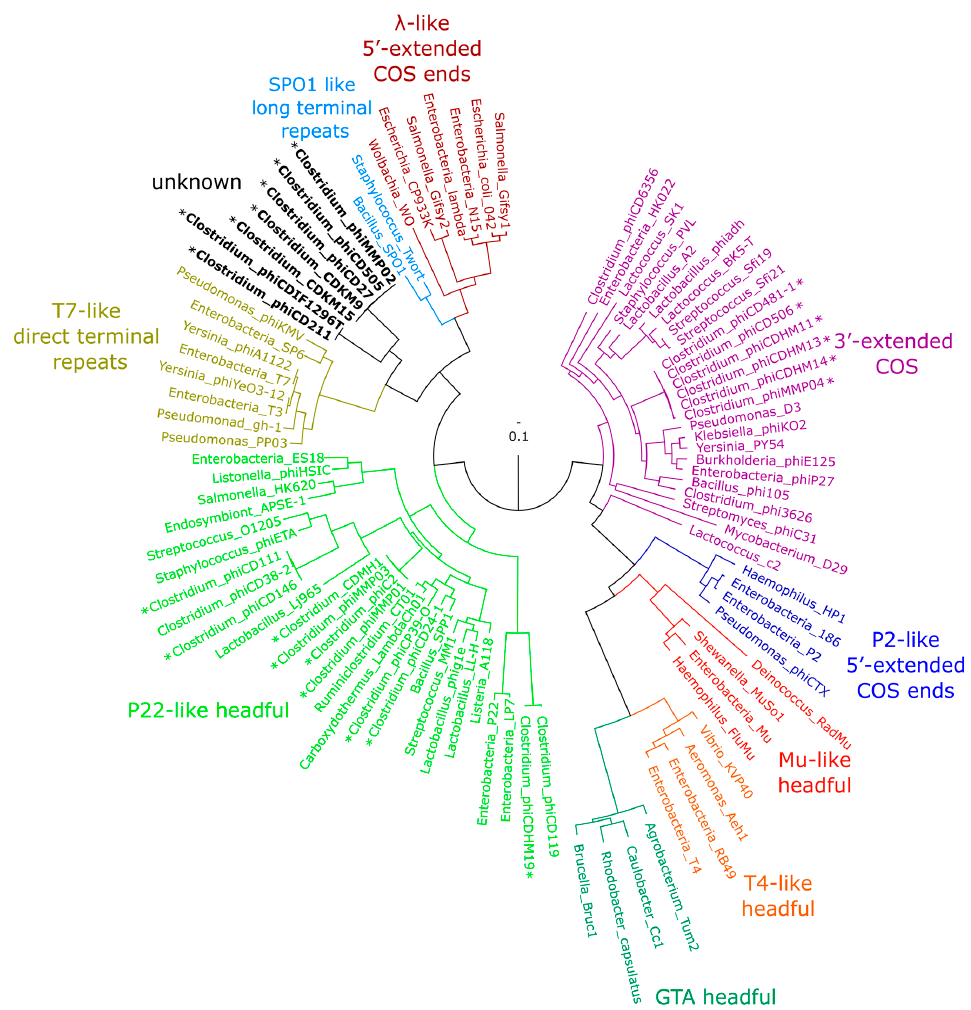
Figure 7. Phylogenetic tree of phage terminase large subunit ( terL ) gene. The name of the phage or prophage is shown at each terminal node and the packaging strategy for each group is labelled where known. The branches are coloured according to the DNA packaging strategy: purple (3 ′‐ cohesive ends), blue (5 ′‐ cohesive ends), red (Mu ‐ like headful), orange (T4 ‐ like headful), jade (GTA headful), green (P22 ‐ like headful), olive (T7 ‐ like direct terminal repeats), black (unknown), light blue (SPO1 long terminal repeat) and maroon ( λ‐ like 5 ′‐ extended COS ends). An asterisk (*) next to a taxon label indicates phages with a packaging strategy predicted during this analysis or earlier predictions using similar methodology, but without experimental evidence (to the best of our knowledge).